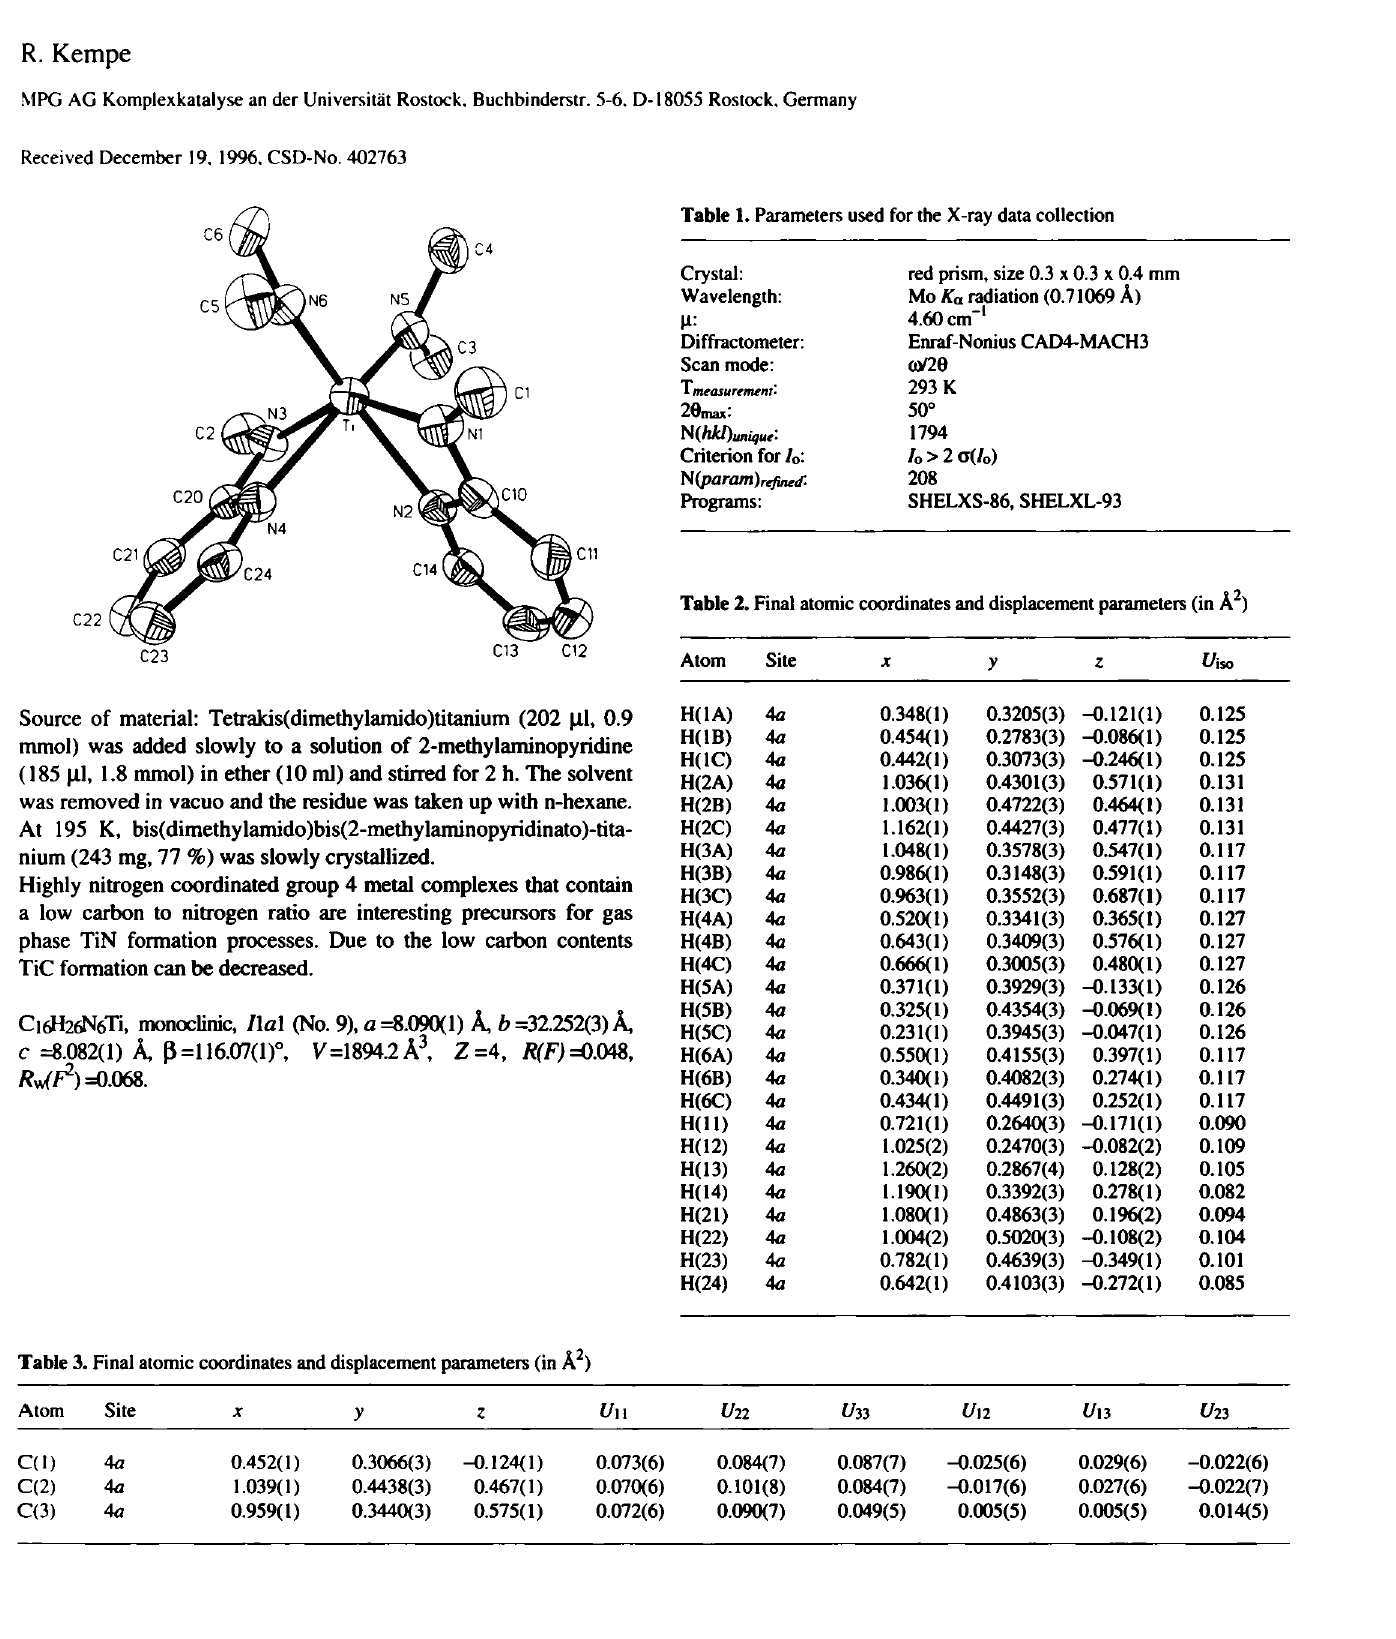
Table 1. Parameters used for the X-ray data collection Crystal: